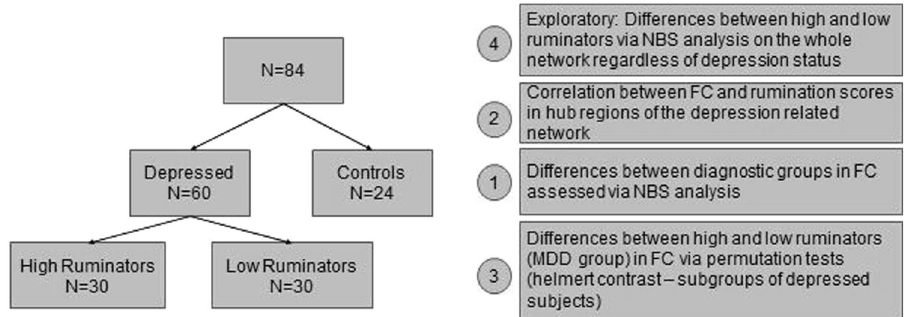
Figure 1. Analysis scheme: Analysis steps 1, 2 and 4 were performed on the whole sample. In the third analysis step, only the depressed subjects were